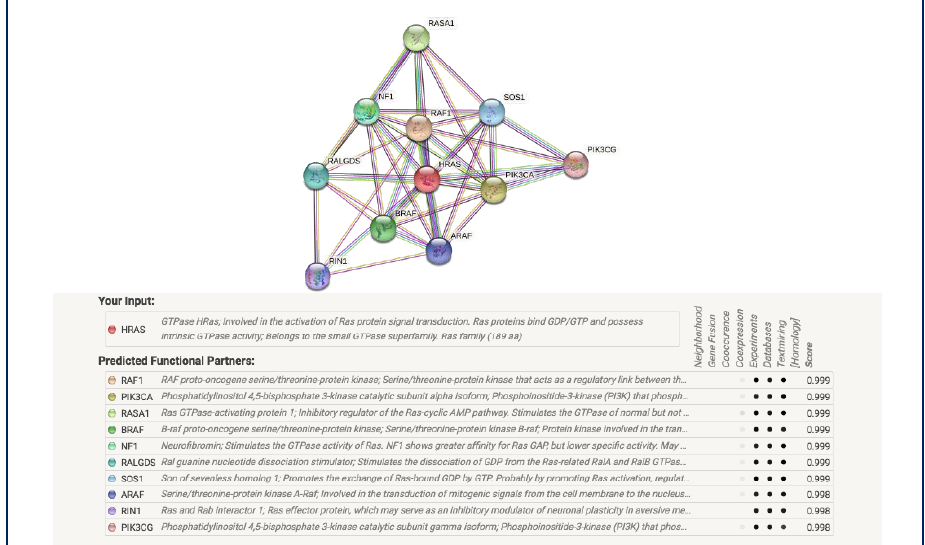
Figure 4. Protein – protein interaction network of HRAS with 10 partners